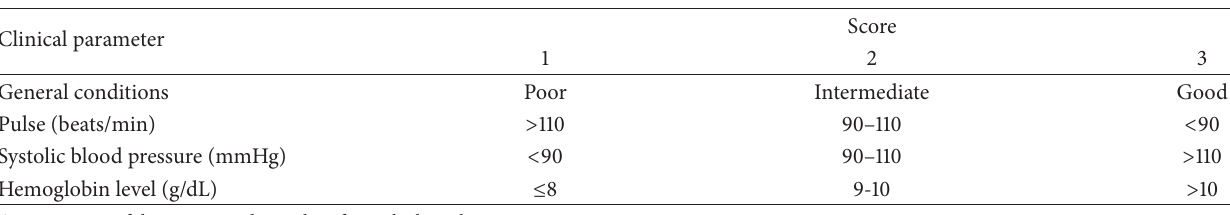
Table 2: Scoring